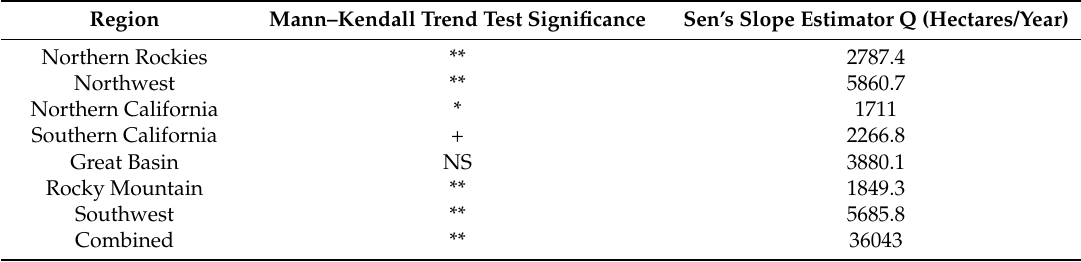
Table 1. Results of non-parametric Mann–Kendall test for significance (* p < 05, ** p < 0.01, + p < 0.1) in temporal trends in wildfire activity for the seven GACC regions and all regions combined during 1980–2015 ( n = 36). The non-parametric slope value Q shows the trends (hectares burned/year) by region over the same